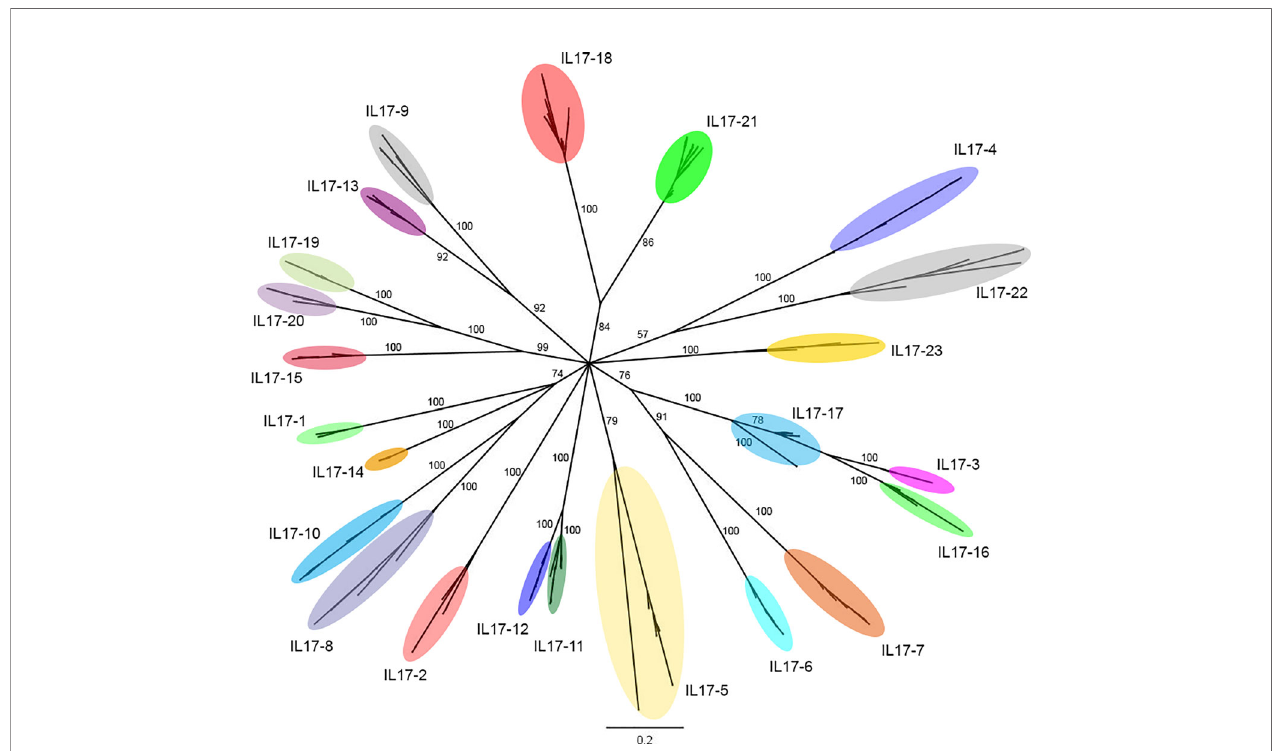
FIGURE 1 | Phylogenetic analysis of the 379 unique IL-17 sequences obtained from the 16 mussel genomes. The 379 unique IL-17 sequences retrieved from 16 mussel genomes were submitted to phylogenetic analysis with Bayesian phylogenetic inference using the Jukes and Cantor (JC) evolution model. The 23 different IL-17 clusters or isoforms obtained are indicated with ellipses that englobe all their unique variants. The fi gure shows branch posterior probabilities. It can be seen how isoforms IL17-3 and IL17-16 would be diverging from IL17-17, since the branch of the latter contains both isoforms. The distinction between these isoforms was maintained due to the homology criterion and to expression